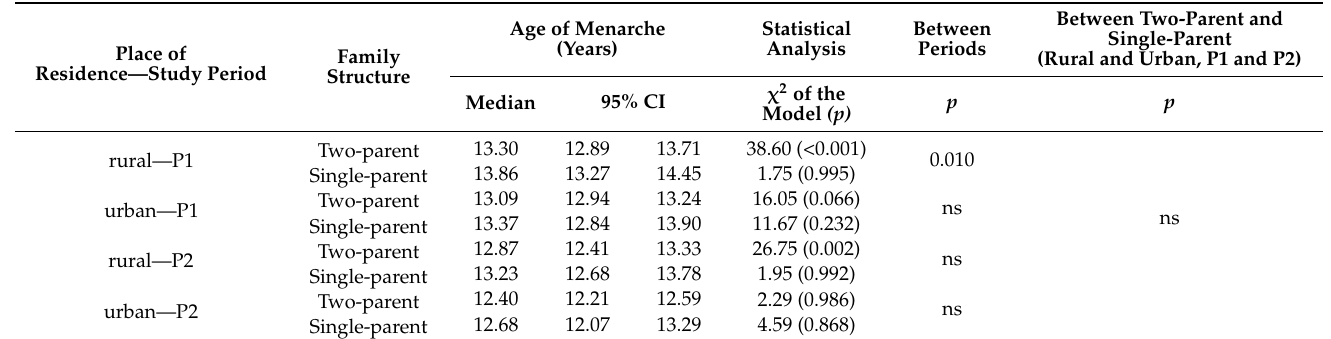
Table 4. Medians with 95% confidence intervals and χ 2 of the fitted probit models for estimated ages of menarche for rural and urban girls according to study period(P1 and P2 cohorts) from two-parent and single-parent families.